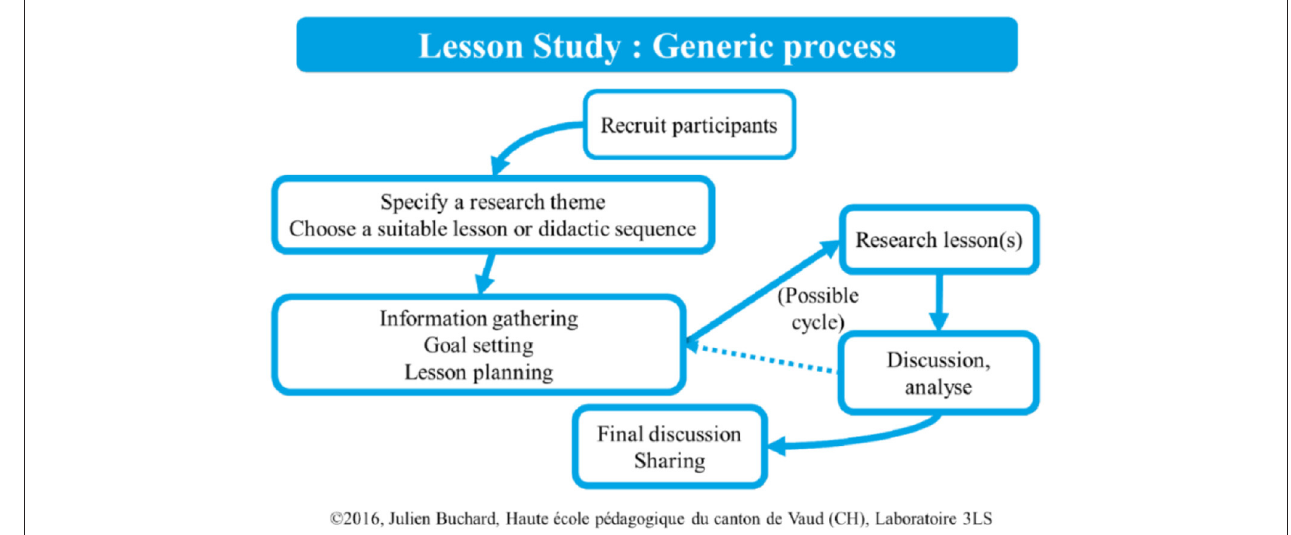
FIGURE 1 | The essential Lesson Study Features (Buchard and Martin, 2017, p. 13).